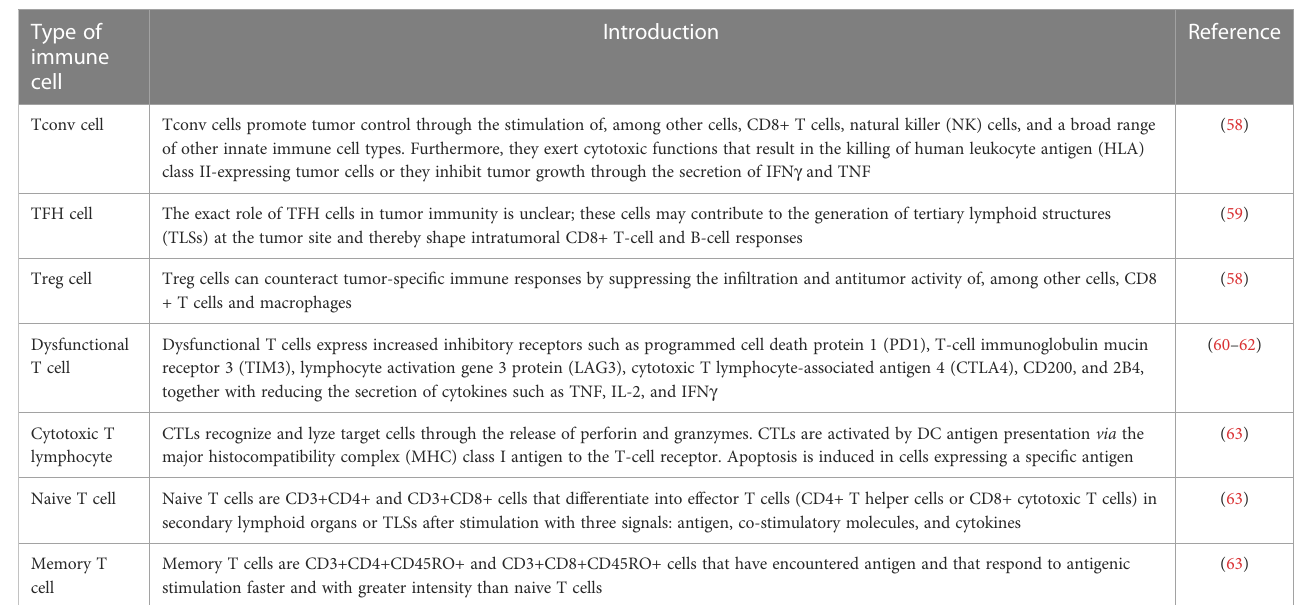
TABLE 1 Types of immune cells in tumors and their functions.